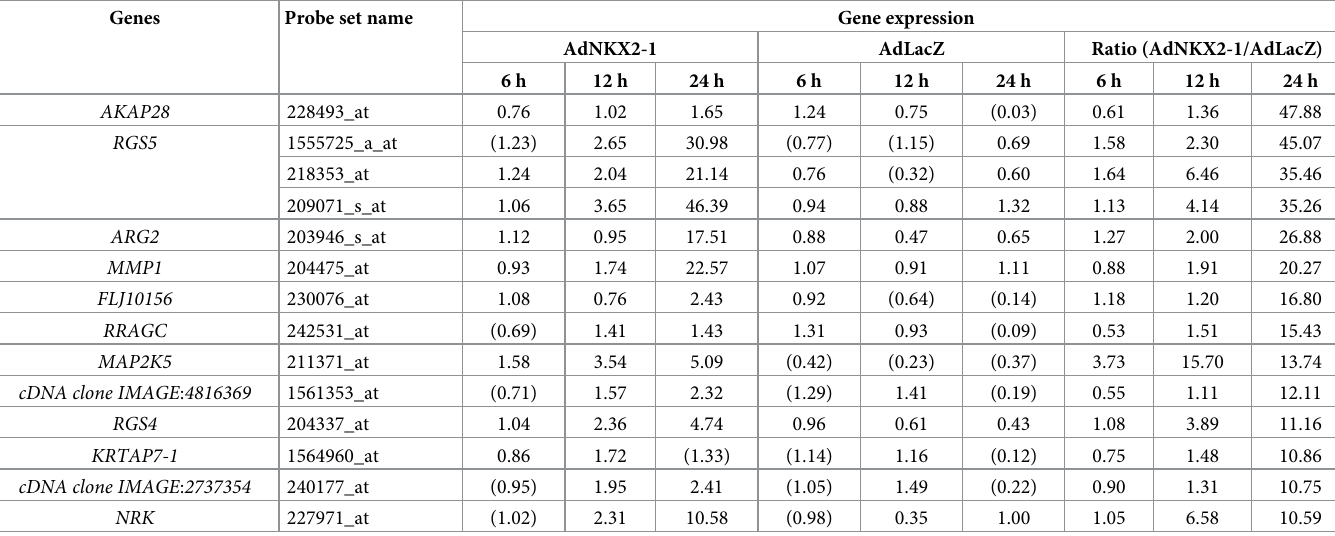
cDNA clone IMAGE :